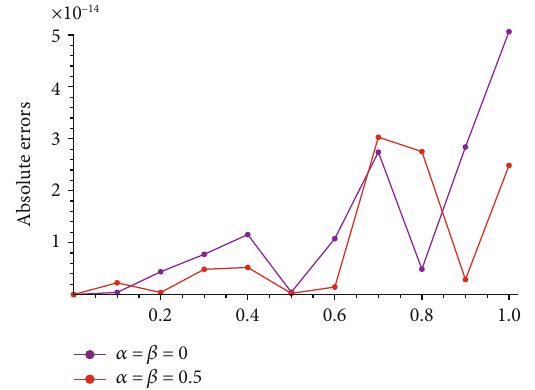
Figure 16: Absolute errors of u 2 obtained by the present method with α = β = 1/2 (red), α = β = 0 (purple) for Example 2.